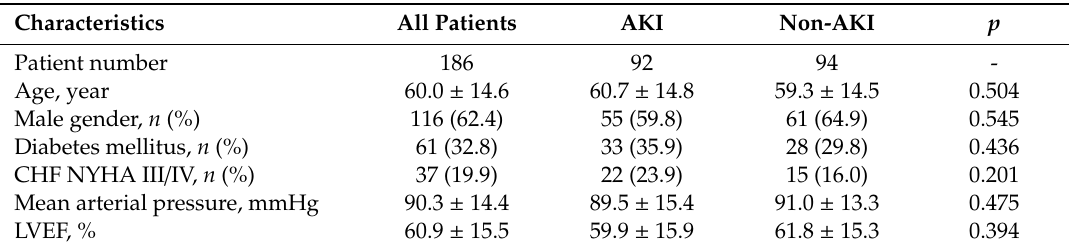
Table 1. Baseline characteristics of the patients with and without AKI after cardiac